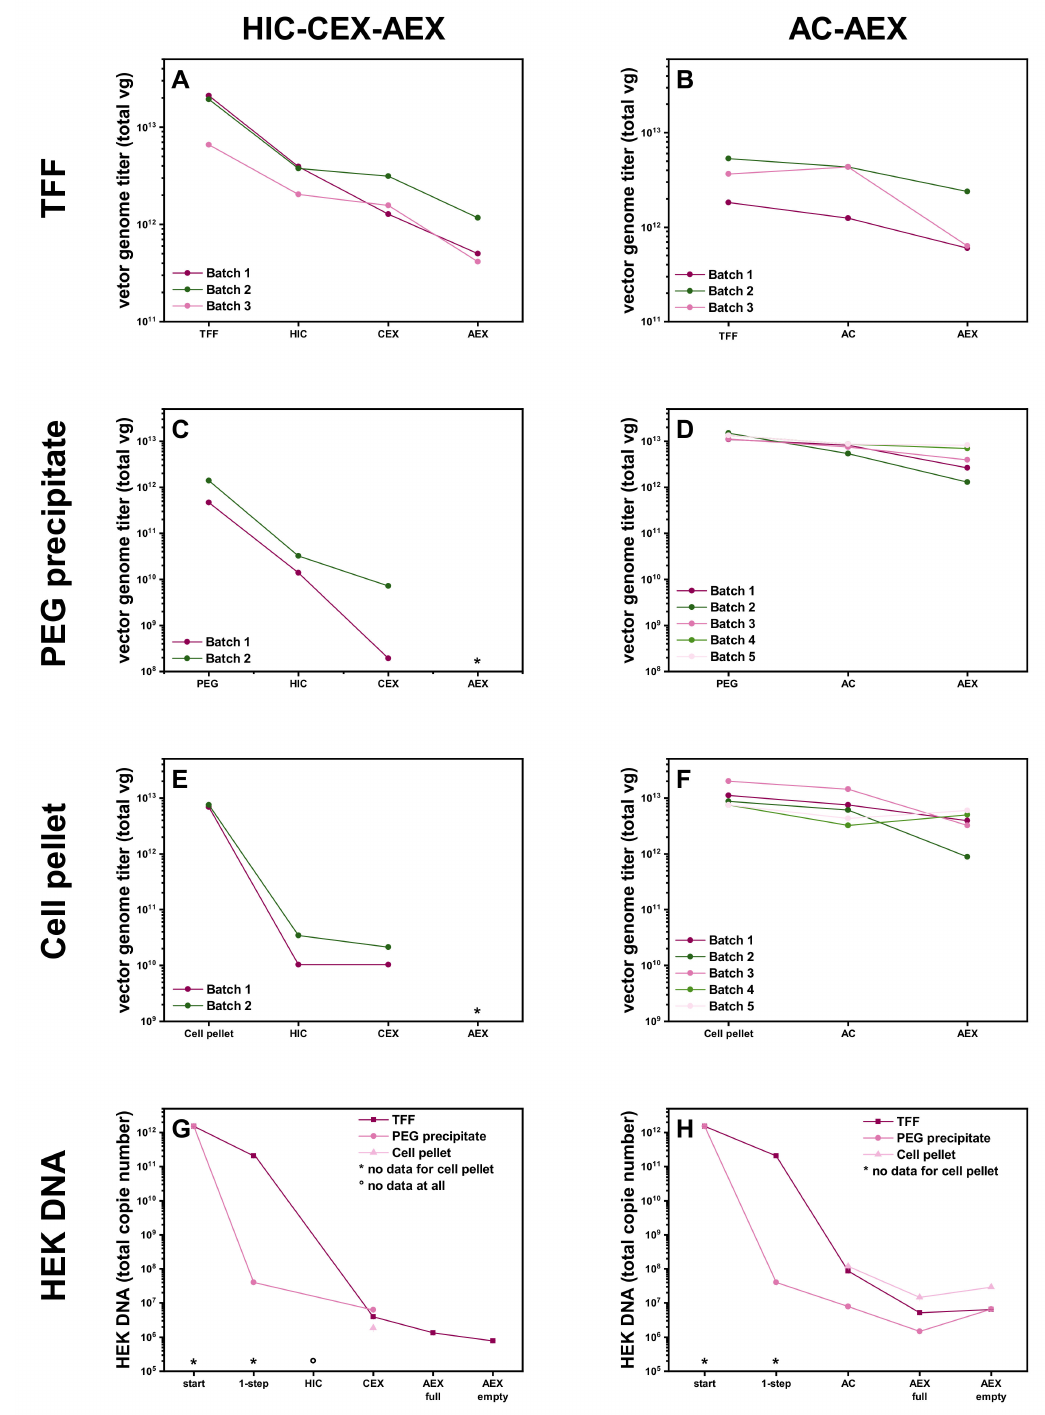
Figure 3. Effect of different harvesting methods on the rAAV2/8 vector production yield and pureness of the human embryonic kidney (HEK) 293T cell DNA . ( A – F ) Graphs showing the yield (total vector genomes, vg) for the rAAV2/8 vectors obtained with the two strategies, with materials harvested from ( A , B ) the cell culture supernatant and cell pellet lysate filtered, concentrated, and buffer-exchanged by tangential flow filtration (TFF) ( n = 3). ( C , D ) Culture supernatant by polyethylene glycol (PEG) precipitation ( C ), followed by HIC-CEX ( n = 2) and ( D ) followed by AC-AEX ( n = 5) or ( E , F ) cell pellet lysate ( E ) followed by HIC-CEX ( n = 2) and ( F ) followed by AC-AEX ( n = 5). ( G , H ) Graphs showing the removal efficiency of the strategies for HEK cell DNA at all the purification steps. AC, affinity chromatography; AEX, anion exchange chromatography; CEX, cation exchange chromatography; HIC, hydrophobic interaction chromatography; PEG, polyethylene glycol; rAAV, recombinant adeno-associated